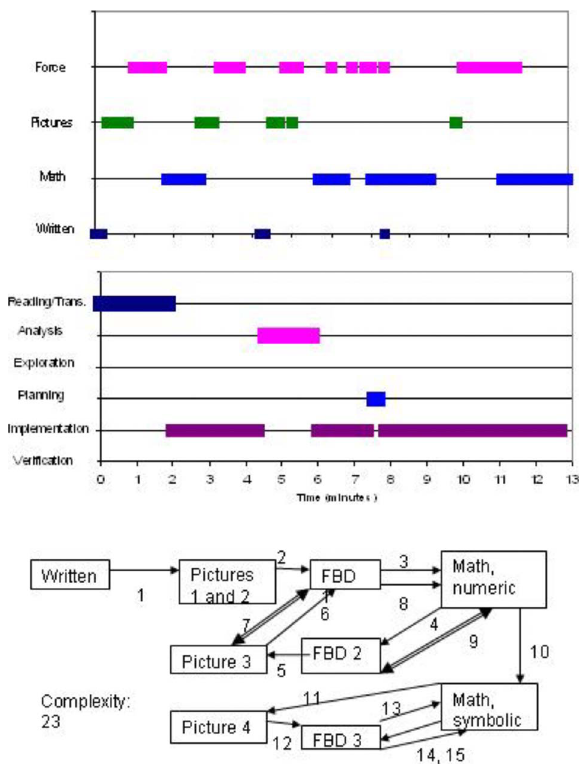
FIG. 8. (cid:1) Color online (cid:2) Three codings of novice Carrie’s at- tempted solution of the electrostatics challenge problem. Above, we have the representations used as a function of time. The middle graph shows how these representations were being used. On the bottom, we have the sequence of representations used. Some quick translations back and forth have been removed for